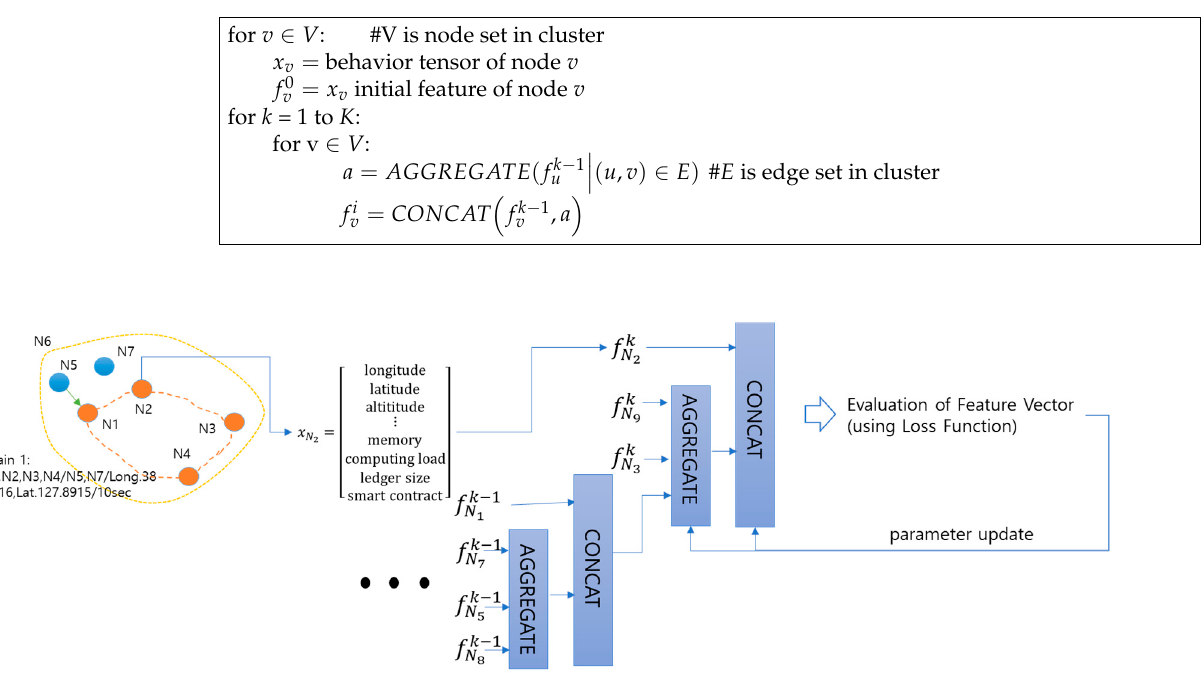
Figure 5. Example of GNN training.